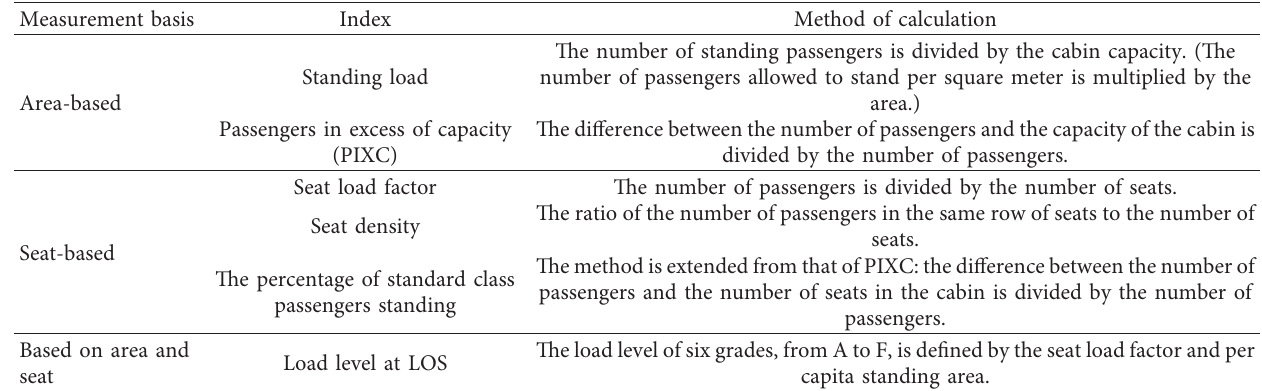
Table 2: Calculation method of the cabin